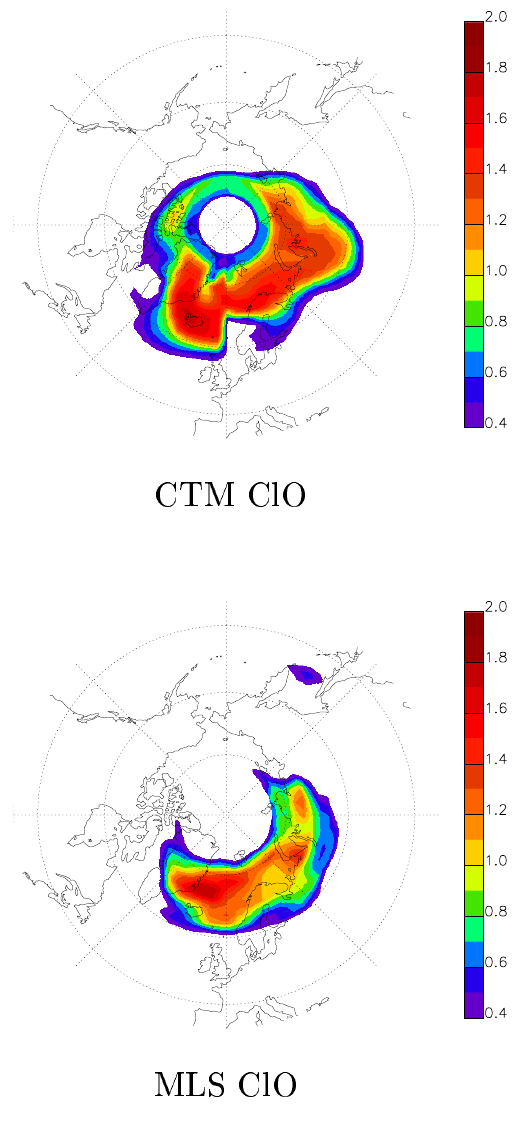
Fig. 3. As in Fig. 2, but for 24 February